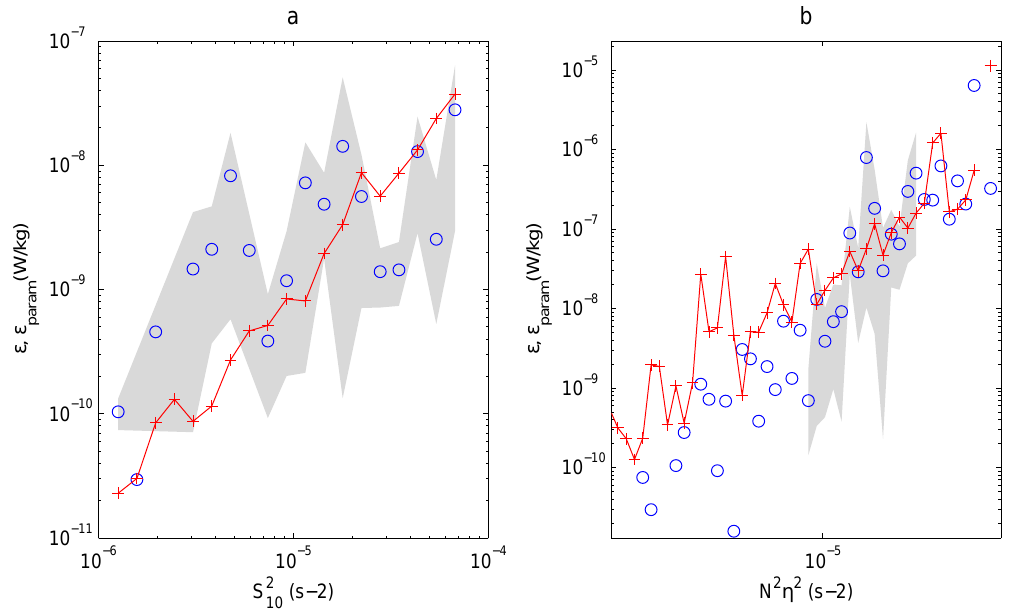
Fig. 10. Averaged dissipation rate (cid:15) (blue circles) and parameterized dissipation rate (cid:15) param (red line) calculated in bins of shear S 2 Figure 10: Averaged dissipation rate ϵ (blue circles) and parameterized dissipation rate ϵ param buoyancy scaled strain N 2 ζ 2 , the gray shading represents the 95% confidence interval calculated when at least 10 data point were averaged and buoyancy scaled strain N 2 ζ 2 , the gray shading (red line) calculated in bins of shear S 2 10 in a represents the 95 % con(cid:28)dence interval calculated when at least 10 data point were averaged in a bin.